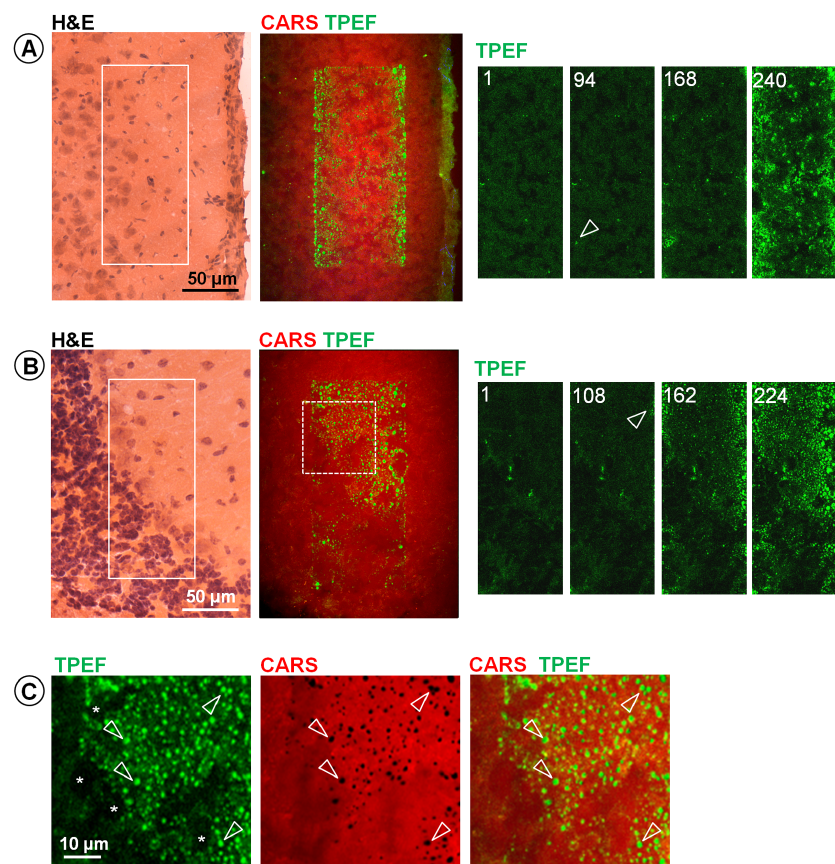
Figure 3. Endogenous fluorescence induced by multiphoton microscopy on rehydrated cryosections of mouse brain. A : Multiphoton image of cortical tissue after 240 scans in the area indicated by the box and TPEF images showing the irradiated area at scan n. 1, 94, 168 and 240; the arrow indicates the very first increase of TPEF at scan 110. B : Cerebellar tissue after 224 scans in the area indicated by the box and TPEF images showing the irradiated area at scan n. 1, 108, 162 and 224; the arrow indicates the very first increase of TPEF at scan n. 108. In both cases H&E staining of a consecutive section is provided as reference for tissue structures. C : Magnified image of the region indicated by the dashed box in B: TPEF (green) and CARS (red) are shown separately and merged. Arrows indicate spots of strong TPEF that colocalize with decreased CARS signal intensity. All experiments were performed with a total laser power of , 52 mW in the sample.